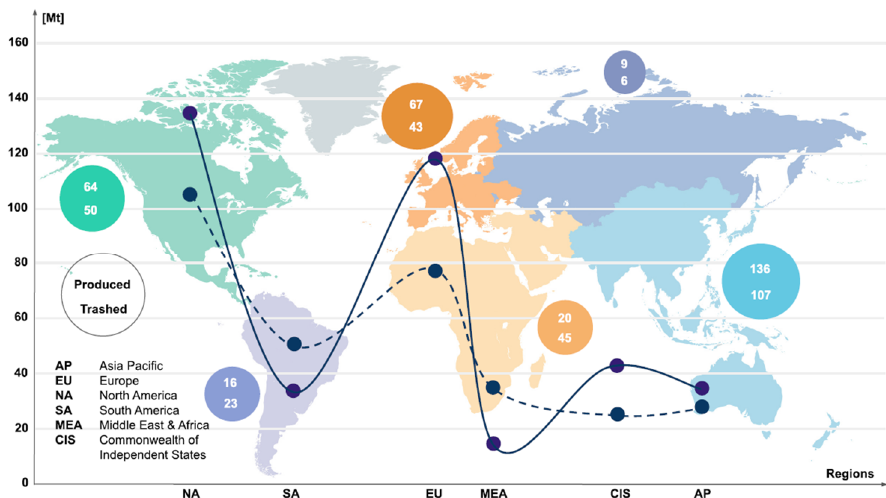
Figure 1. Annual virgin plastic produced (top) and trashed as waste (bottom) in million tonnes [Mt] for different shaded regions in 2010. Per capita virgin plastic production (solid) and waste generated (dotted) for different shaded regions.